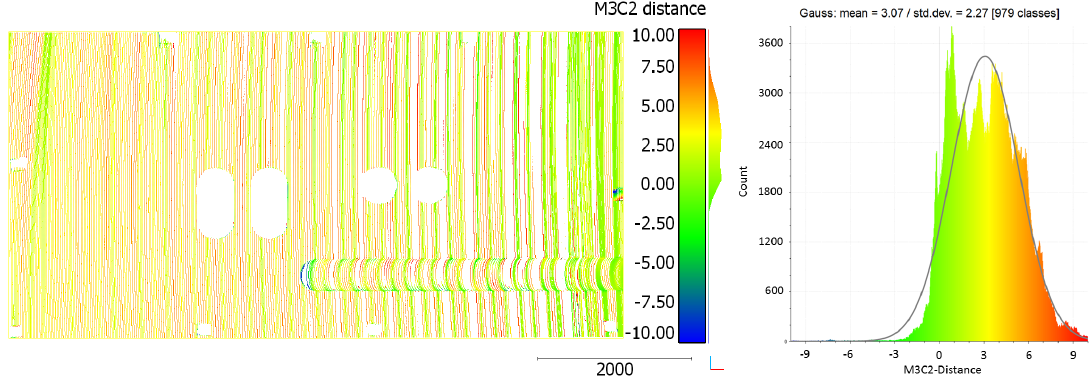
Figure 7. Computed 3D distance (M3C2) between s-TLS and k-TLS with no motion model.